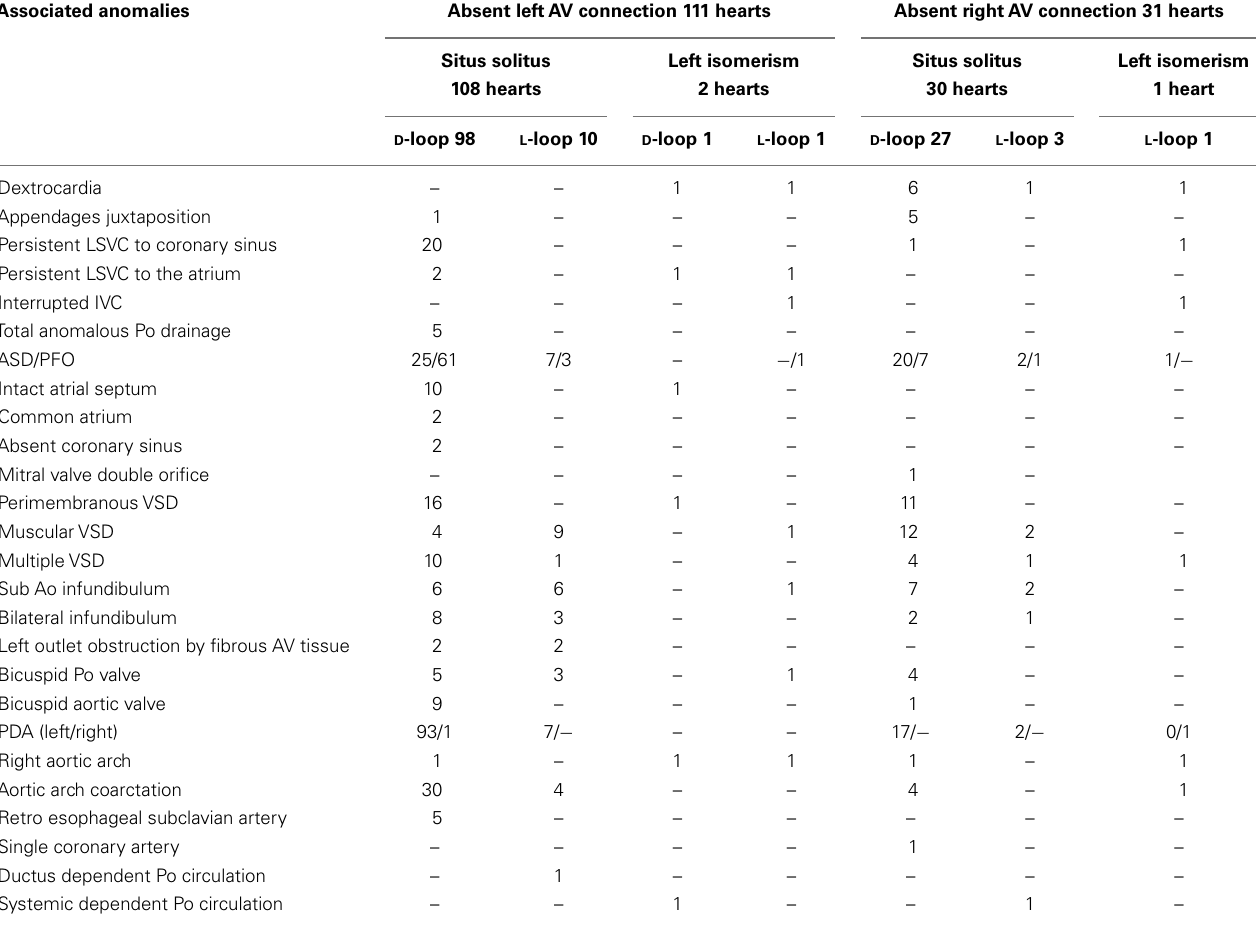
Table 7 |AbsentAV connections: associated anomalies